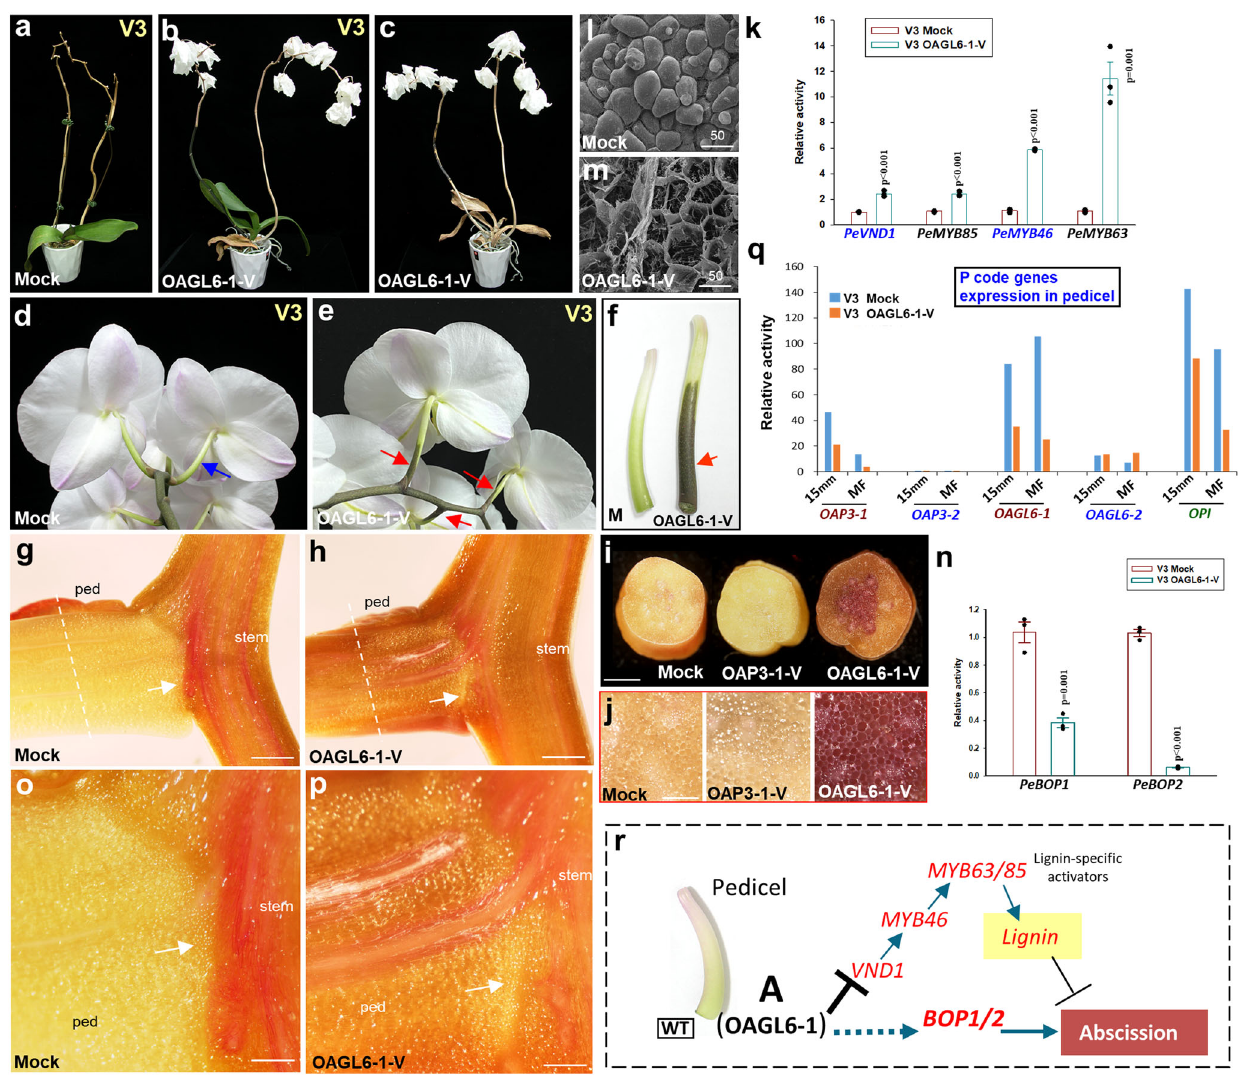
Fig. 4 The OAGL6-1 protein regulated pedicel abscission in orchids. a , b The fl owers were senescent and abscised completely from the control (Mock) in fl orescence ( a ), whereas senescent fl owers were not abscised from the OAGL6-1 -VIGS in fl orescence ( b ) of Phalaenopsis V3. c The senescent fl owers were still not abscised three months after the plant ( b ) had completely dried. d – f The back views of fl owers of the control (Mock) ( d ) and OAGL6-1 -VIGS ( e ) Phalaenopsis V3. A dark brown color was observed in the pedicel of OAGL6-1 -VIGS (red arrow in ( e , f )) but was absent in the control (Mock) pedicel (blue arrow in ( d )) ( f ). g – h The longitudinal views for pedicels (ped) and the connected stems of the control (Mock) ( g) and OAGL6-1 -VIGS V3 ( h ) after staining by phloroglucinol. The arrows indicate the AZ in the junction of the pedicel and stem. The dashed lines indicate the place used for the cross view in ( i , j ). Bars = 1 mm. i Cross view of the pedicels of the control (Mock), OAP3-1 -VIGS and OAGL6-1 -VIGS V3 (from left to right) after staining by phloroglucinol. Bars = 1 mm. j Close-up image of the phloroglucinol-stained pedicels from ( i ). Bars = 100 µ m. k , n Analysis of the expression levels of PeVND1 , PeMYB85 , PeMYB46 , and PeMYB63 ( k ) as well as PeBOP1 and PeBOP2 ( n ) in the pedicels of control (Mock) and OAGL6-1 -VIGS V3 fl owers. Error bars show ±SEM. n = 3 biologically independent samples. The p value indicates signi fi cant differences from the control (Mock) value. The statistical test used was two-sided according to Student ’ s t -test. l , m SEM image of pedicel AZs in control (Mock) ( l ) and OAGL6-1 -VIGS ( m ) V3 fl owers. Bars = 50 µ m. o , p Close-up of the phloroglucinol-stained junctions for the pedicel (ped) and the stem of the control (Mock) ( o ) and OAGL6-1 -VIGS V3 ( p ) from ( g , h ). The arrows indicate the AZ region with the small differentiated cells formed. The cells in the AZ region in ( p ) were altered by the penetration of lignin from the pedicel to the stem. Bars = 300 µ m. In ( j , l , m , o , p ), each experiment was repeated twice independently with similar results. q Analysis of the expression levels of OAP3-1 , OAP3-2 , OAGL6-1 , OAGL6-2 , and OPI in 15 mm and mature fl ower pedicels of control (Mock) and OAGL6-1 -VIGS V3 fl owers. The data were derived from one NGS data. r In wild-type orchid fl owers, OAGL6-1 proteins may form an abscission complex (A) to promote the abscission of pedicels by suppressing the expression of VND1/MYB46/63/85 and lignin formation and to ensure the normal BOP1/2 expression and subsequent AZ formation. Source data underlying Figs. 4k, 4n, and 4q are provided as a Source Data fi